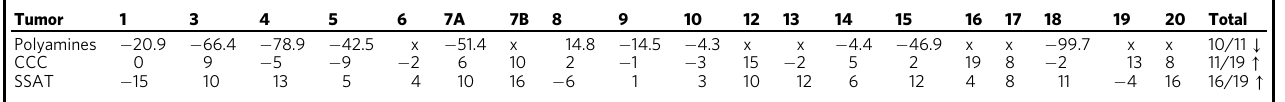
Table 1 Summary of all Patient Tumor Data. Indicated values for each parameter were calculated by subtracting combination treatment (using low dose for tumors 1 and 3, high dose for the remaining tumors) values from vehicle control for each tumor. Polyamine (spermidine + spermine) levels were measured by UPLC and normalized to protein concentration. Cleaved caspase-3 (CC3) and spermidine/spermine N1-acetyltransferase (SSAT) scores were determined based on the estimated percent positive cells multiplied by intensity of staining. The fi nal column indicates the number of tumors that increased or decreased for each parameter over the total number of